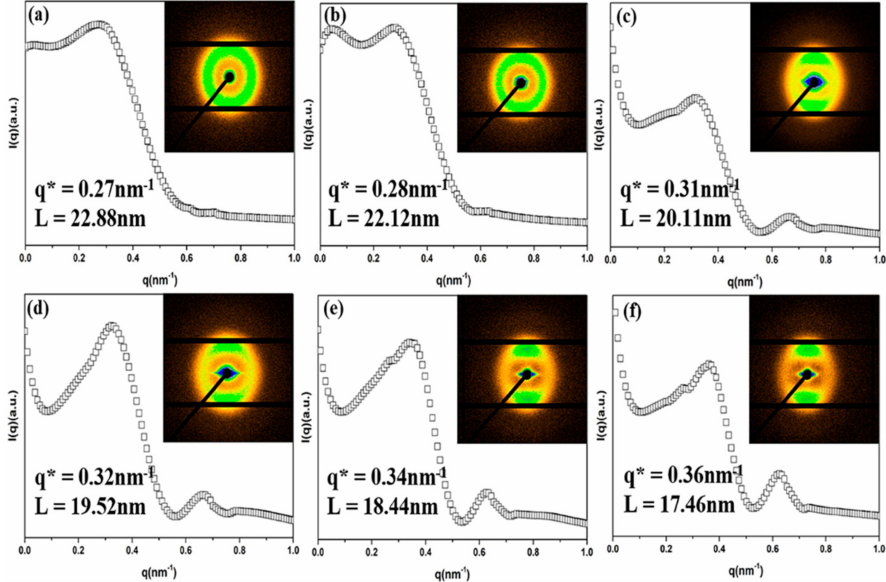
Figure 4. Representative two-dimensional small-angle X-ray scattering (2D-SAXS): patterns and intensity distribution curves in ( a ) pure PP and ( b–f ) PP / PA6 blends with the stretch ratios of 1, 2, 7, 11 and 16, respectively.